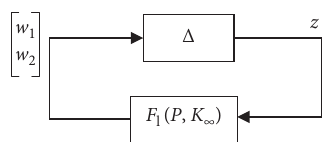
Figure 3: Structure diagram of the uncertainty of coprime factors.